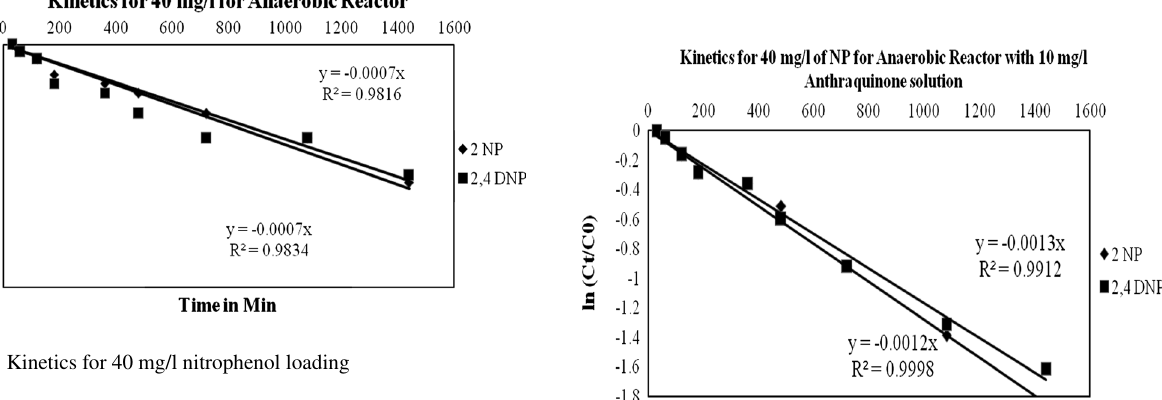
Fig. 15 Kinetics for 40 mg/l nitrophenol loading with 20 mg/l law- sone solution